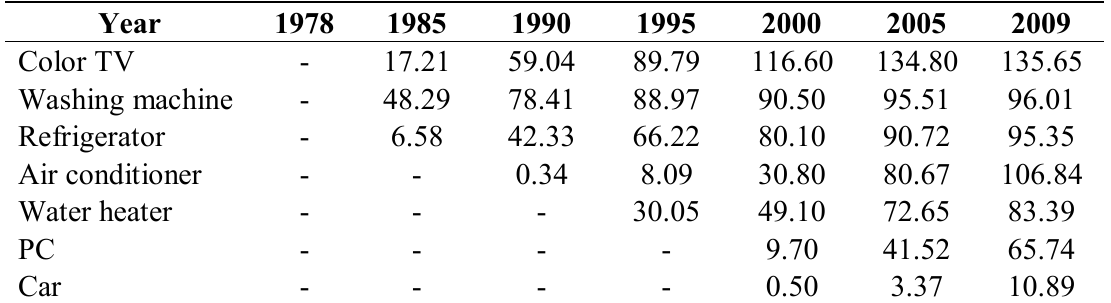
Table 4. Durable goods per 100 families for urban residents in China.